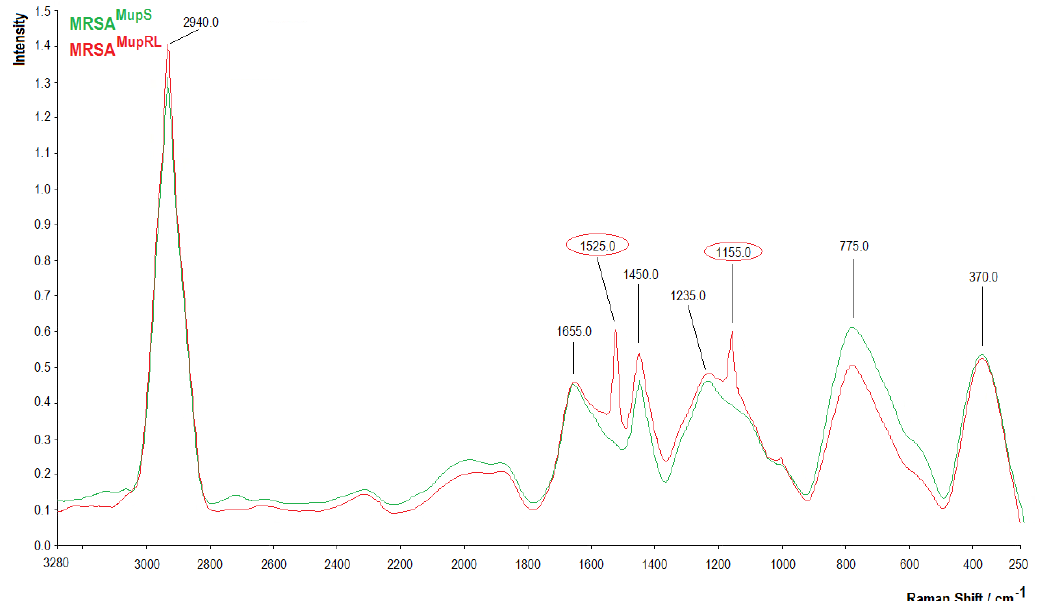
Figure 2. FTIR spectra of MRSA MupS and MRSA MupRL strains. Molecules 2019 , 24 , x FOR PEER REVIEW